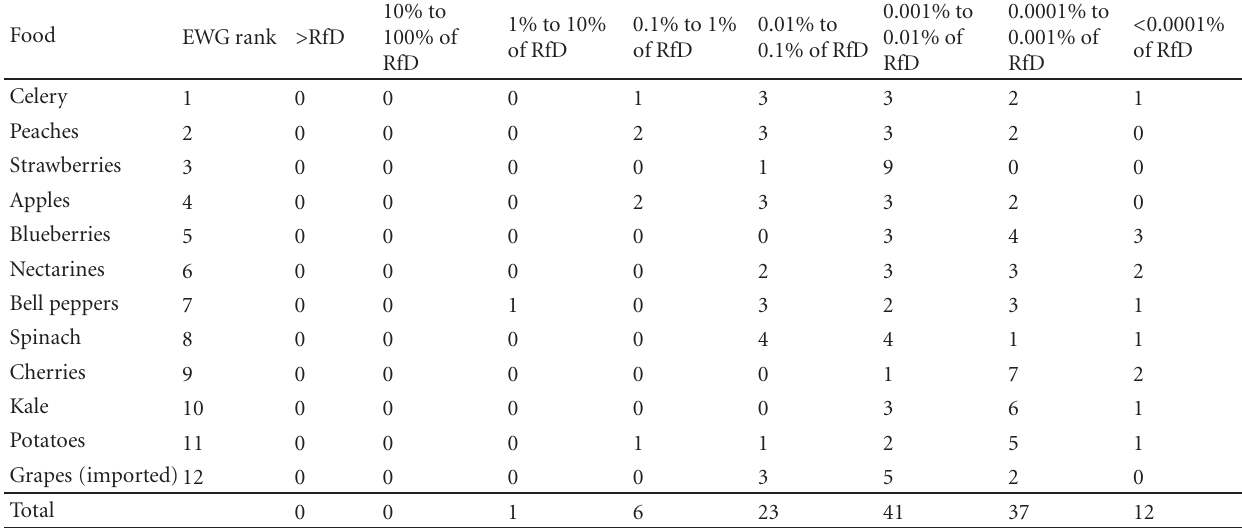
Table 14: Exposure estimates relative to reference doses (RfD) for ten most frequently detected pesticides on twelve